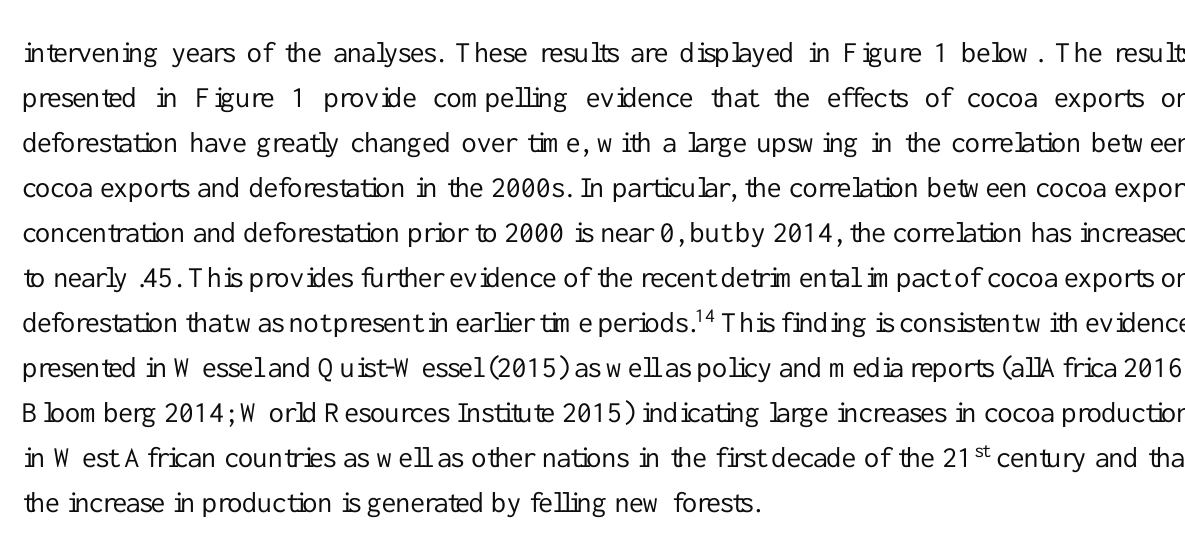
Figure 1. Deforestation and Cocoa Export Dependency Correlation